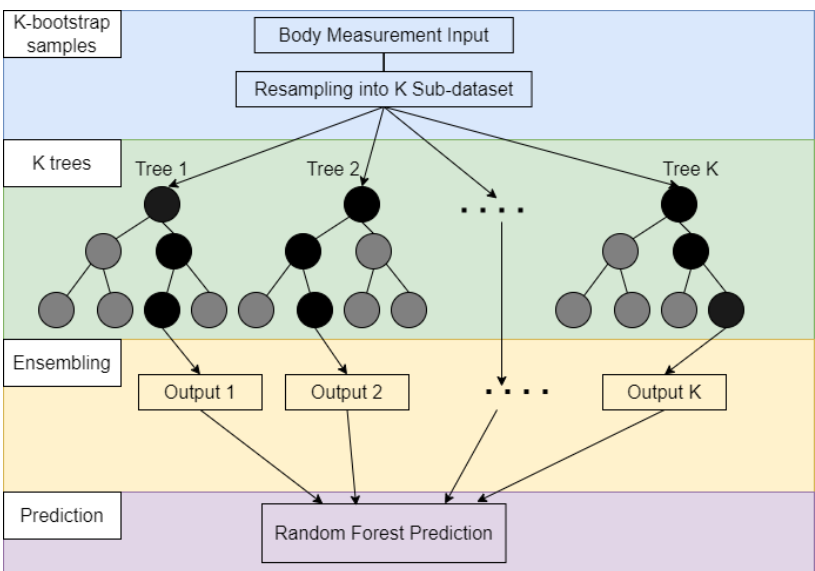
Figure 3. Generic representations of Random Forest (RF)